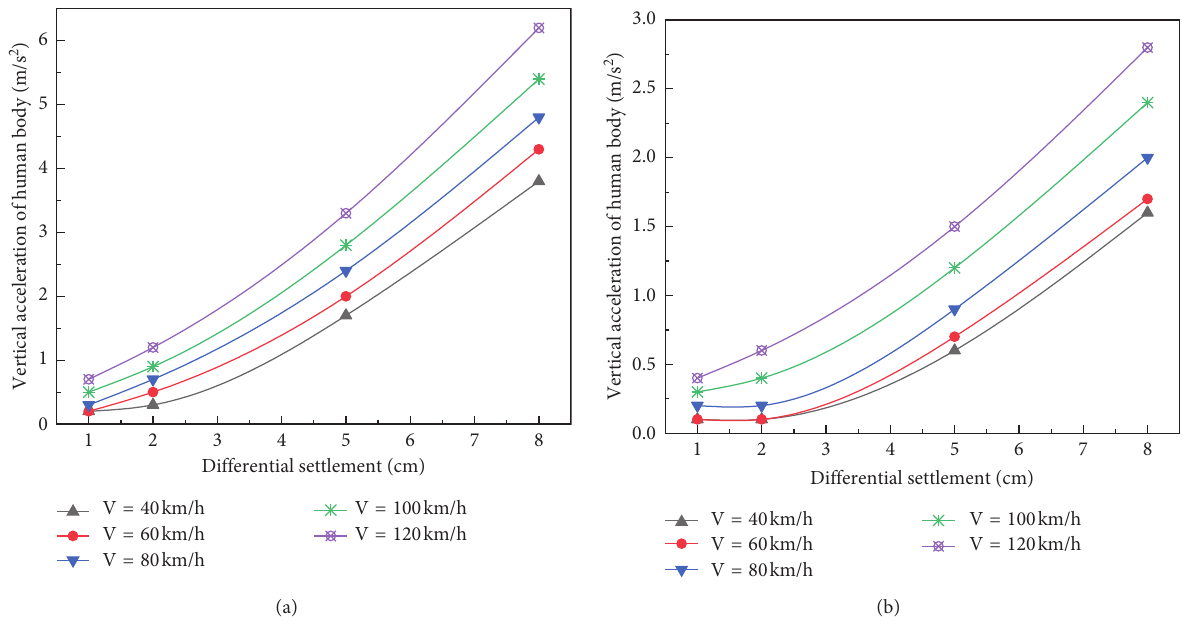
Figure 6: Correlation curve between maximum vertical acceleration of the human body and differential settlement value. (a) Differential settlement length 10m and (b) differential settlement length